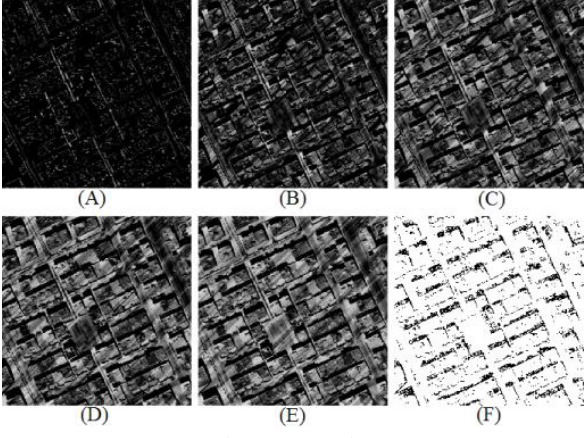
Figure 1. Subtraction of main image from reconstructed image by a SE with 45 degree direction and a scale of, A. 5×5, B.